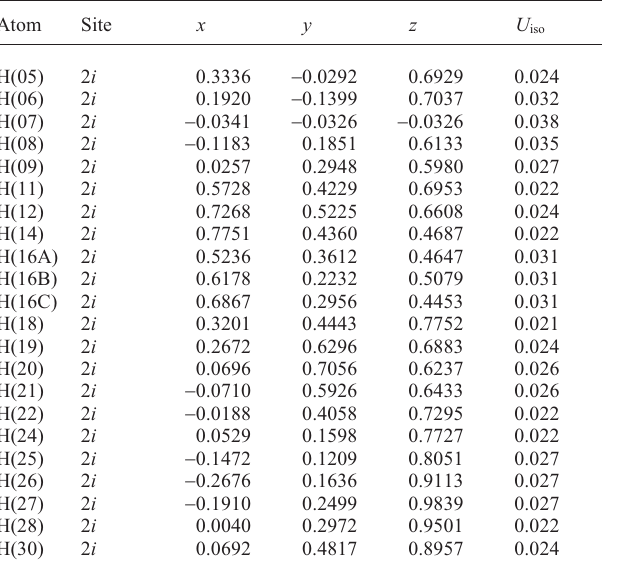
Table 2. Atomic coordinates and displacement parameters (in Å 2 )